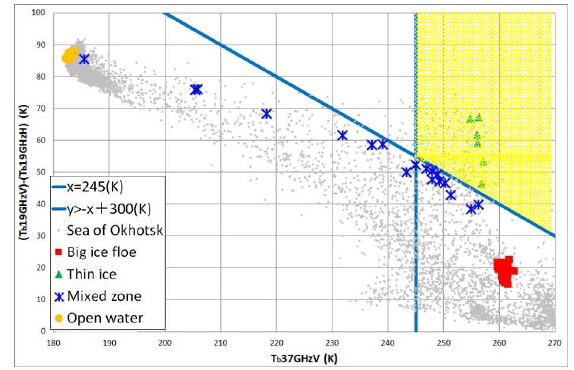
Figure 8. Scatter plots of (19GHzV – 19GHzH) Vs 19G H polarization (Sea of Okhotsk, February 26, 2014)